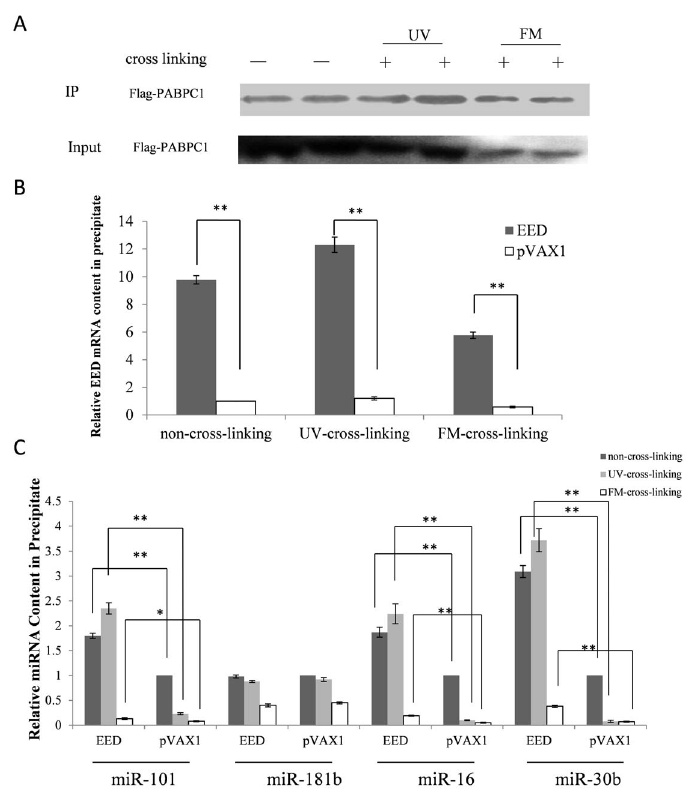
Figure 5. Anti-PABPC1 RNP immunoprecipitation for identifying miRNAs that target EED . (A) Western blot analysis of co-IPed products. Cells were transfected with the EED expression vector, with empty pVAX1 as the control. Cells were treated with 150 mJ/cm 2 UV (lanes 3, 4) or formaldehyde (FM) (lanes 5, 6) 18 h after transfection to cross-link the protein-RNA complex. The cells were then lysed and co-IPed. As expected, the FLAG-PABPC1 proteins were immunoprecipitated with the anti-FLAG antibody and the FLAG-PABPC1 protein contents were nearly the same in the non-cross-linking and UV cross-linking groups. However, the FLAG-PABPC1 amount was reduced in the lysate and precipitate of the formaldehyde treatment group compared to those of the non-cross-linking and UV cross-linking groups. (B) The EED mRNA levels were detected by RT-qPCR and the results were analyzed using the Student’s t-test. P , 0.05 was considered statistically significant. (C) The levels of four selected miRNAs in the precipitate were detected by RT-qPCR. Results were analyzed by the Student’s t-test. * P , 0.05, ** P ,